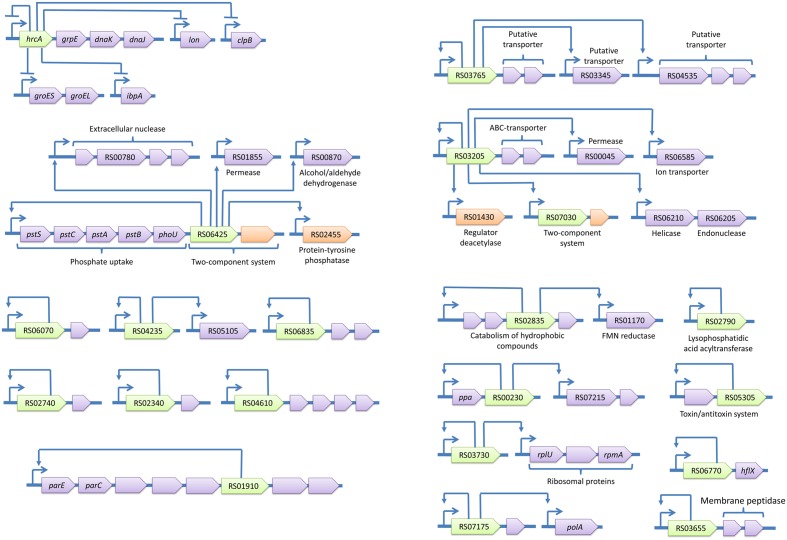
Transcriptional regulons of A. laidlawii. Green genes represent TFs with predicted binding sites, violet genes are target genes and orange genes are non-transcriptional regulators. TSSs of operons are shown by arrows upstream of the genes; other arrows show predicted regulatory relationships between genes.